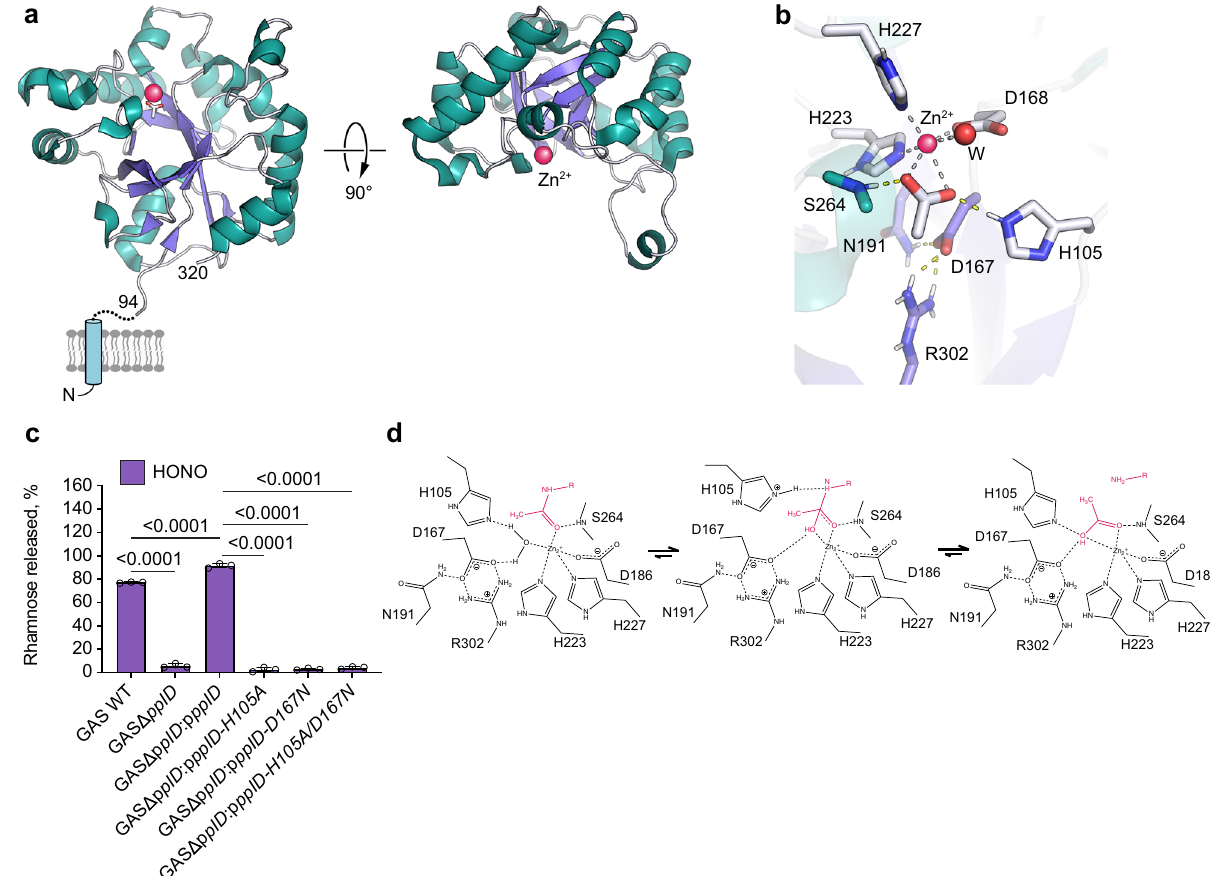
Fig. 5 PplD deacetylates GlcNAc in the GAC-peptidoglycan linkage region. a Predicted topology of PplD showing a transmembrane helix and structure of extracellular domain with the enzymatic active site is depicted on left panel. Right panel depicts the structure of ePplD viewing at the active site with the Zn 2 + ion shown as a magenta sphere. b A close-up view of the active site PplD structure in complex with acetate. c The sacculi puri fi ed from GAS WT, GAS Δ pplD , GAS Δ pplD :p pplD , GAS Δ pplD :p pplD-H105A , GAS Δ pplD :p pplD-D167N , and GAS Δ pplD :p pplD-H105A/D167N were subjected to deamination with HONO. The concentration of GAC released from the sacculi was estimated by the modi fi ed anthrone assay and normalized to total GAC content in the analyzed materials. Symbols and error bars represent the mean and S.D., respectively ( n = 3 biologically independent replicates). P values were calculated by one-way ANOVA with Tukey ’ s multiple comparisons test. Source data for ( c ) are provided as a Source data fi le. d Proposed catalytic mechanism for PplD-mediated deacetylation of the GAC-peptidoglycan linkage